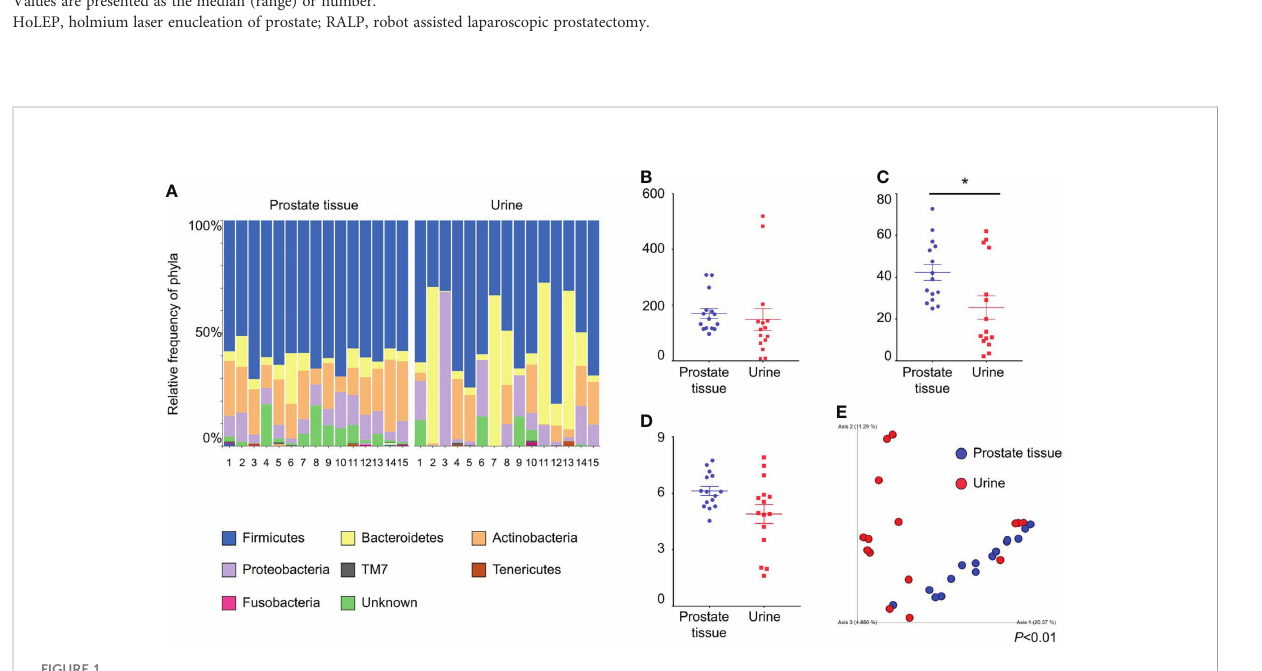
FIGURE 1 Comparison of alpha and beta diversity of the microbiota of prostate tissue and catheterized urine from 15 patients each. (A) Relative frequency of bacterial phyla in each sample. Each bar represents a subject sample, and each colored box represents a bacterial phylum. The height of a colored box represents the relative abundance of the bacterial phylum in the sample. (B) Chao1 index. (C) Faith ’ s PD index. (D) Shannon index. The date represents the mean and the SEM. (E) PCoA plots based on unweighted UniFrac distance. * P <